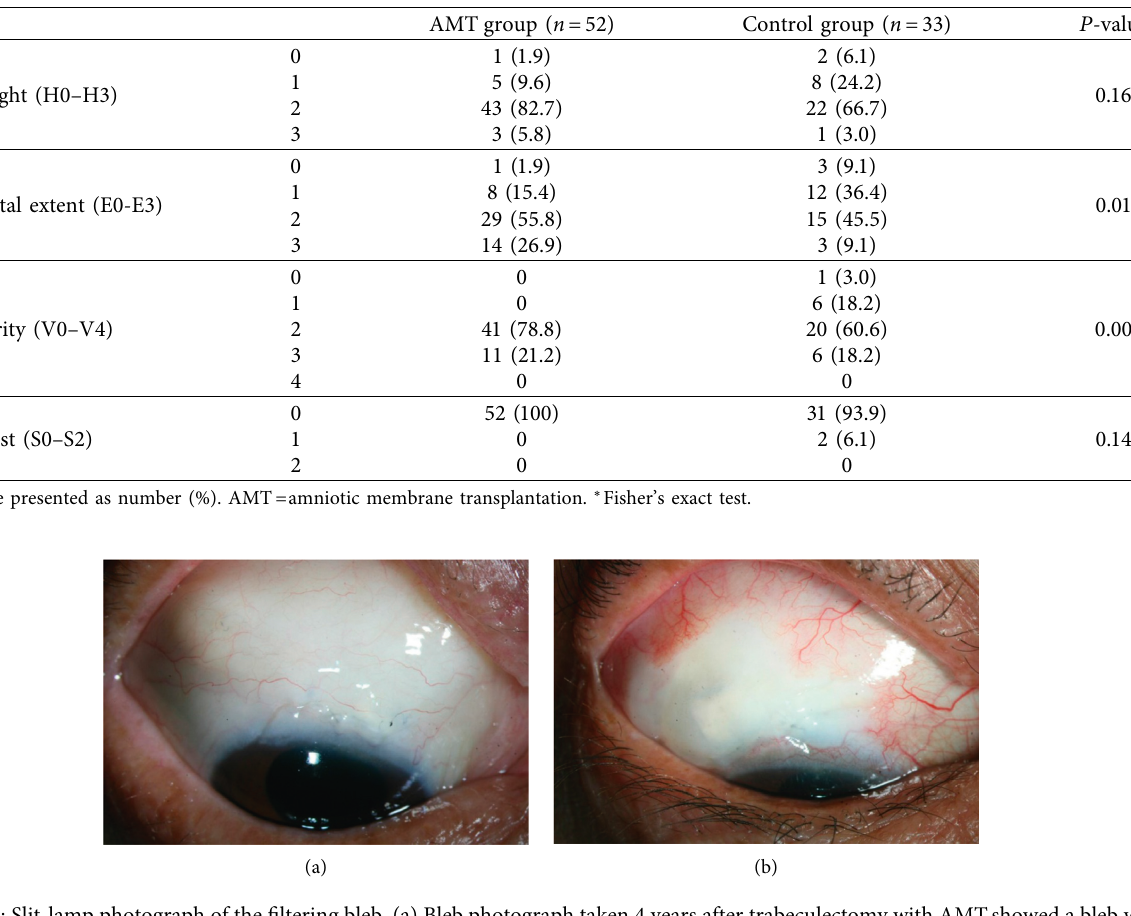
Table 4: Comparison of bleb morphology based on indiana bleb appearance grading scale in both groups.